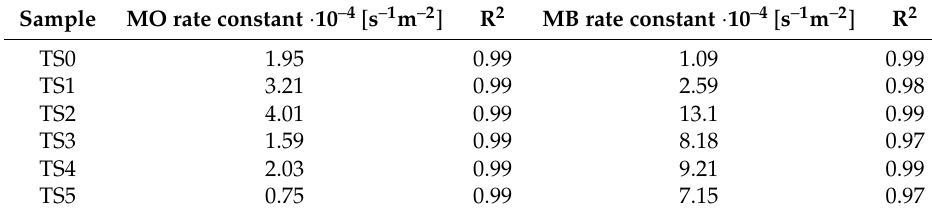
Table 2. SSA ext. normalised apparent rate constants of the first 30 min of methyl orange (MO) degradation and methylene blue (MB) degradation of different core-shell